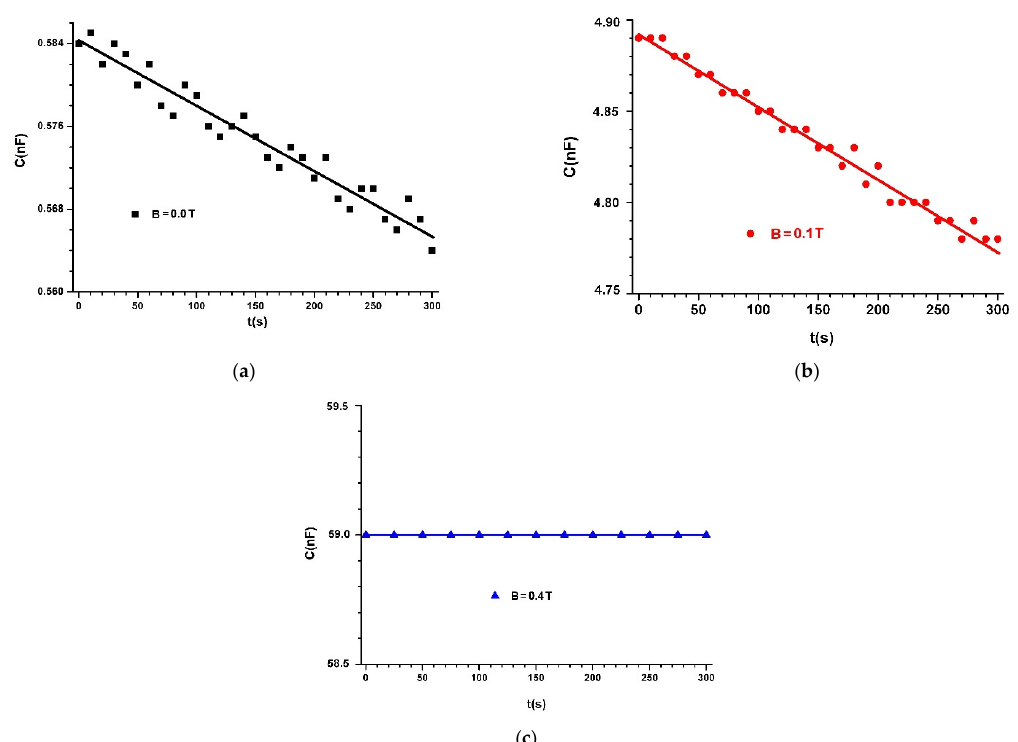
Figure 8. Electric capacitance of MC 3 capacitor placed in a magnetic field with magnetic flux density of: ( a ) B = 0.0 T; ( b ) B = 0.1 T; ( c ) B = 0.4 T. Dots are experimental data and lines indicate linear